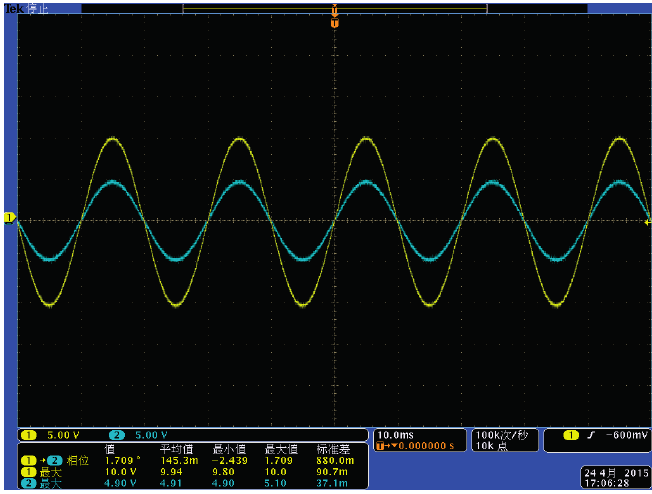
Figure 19. Comparison diagram of waveform under the voltage class of 2 kV.